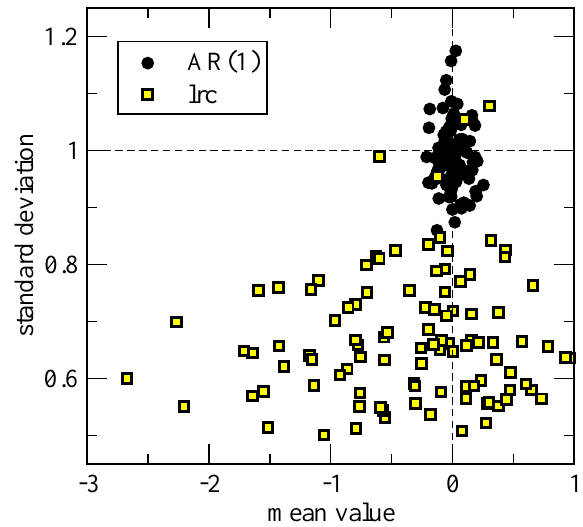
Fig. 3. Scatter plot of the individual mean values and standard devi- ations for two sets of model time series. The first series is produced by the AR(1) model Eq. (1) with the parameters fitted to the monthly SST signal. The second long-range correlated (lrc) signal of spec- tral exponent β = 0 . 6 is produced with the inverse Fourier method, see e.g. Fox (1987). Both time series of 185500 data points are split into 100 equal pieces, and the individual means and standard deviations are plotted (see legends).